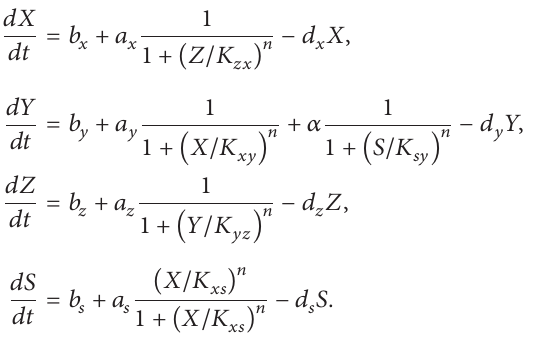
Figure 2: Bifurcation diagram of component 𝑋 versus parameter 𝛼 about model